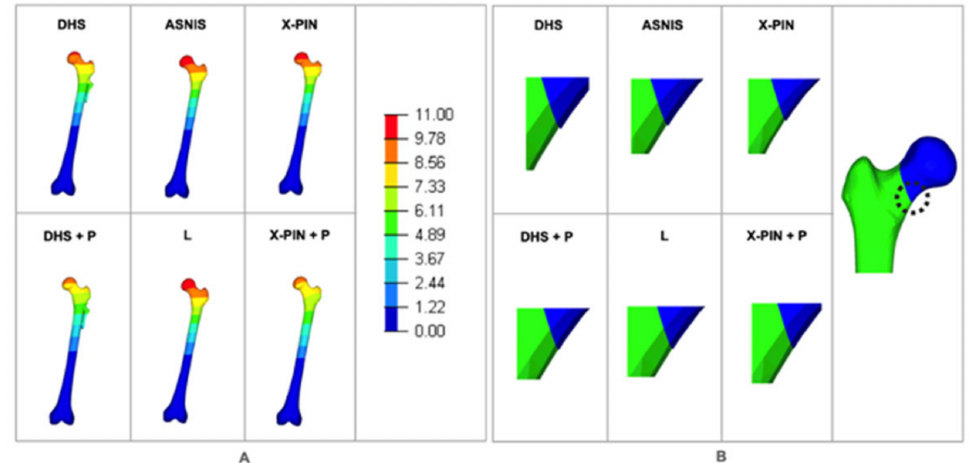
Figure 9. ( A ) Total displacement for each model; ( B ) localized displacement for each model. Finally, the von Mises values were 859, 1005, 448, 393, 955, and 1195 MPa, with the X-PIN+P results 18% and 166% higher than DHS+P and ASNIS, respectively (Figure 10).